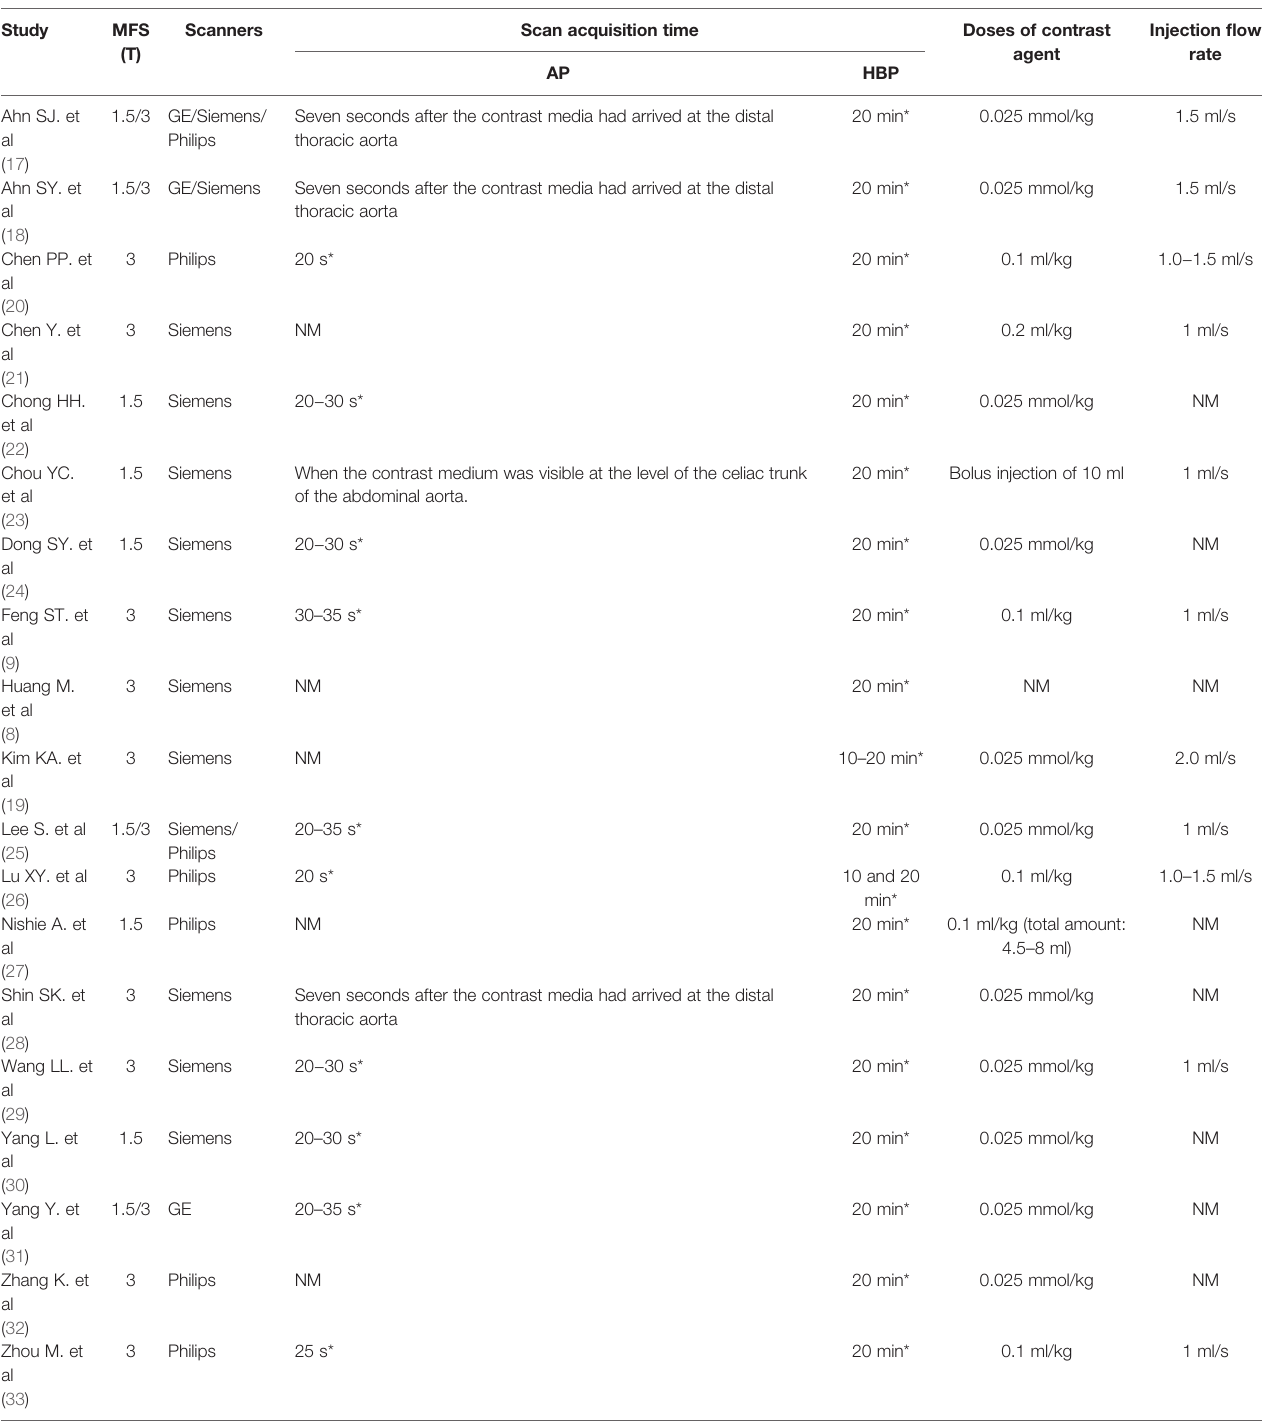
TABLE 2 | Characteristics of imaging